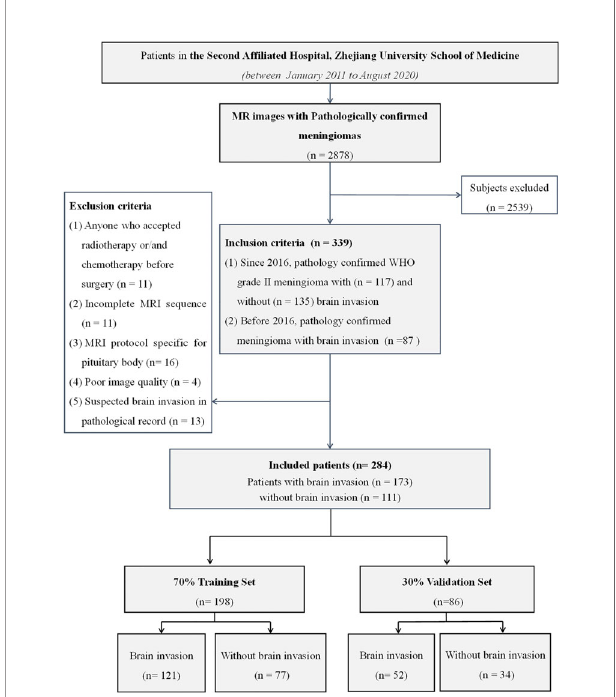
FIGURE 1 | The fl owchart of data inclusion and